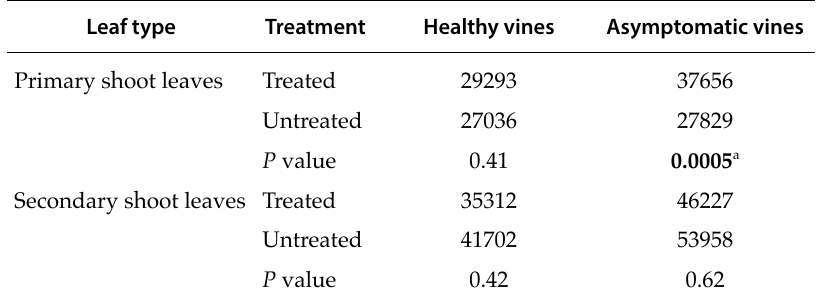
Figure 3 . Incidence and severity of esca foliar symptoms in two vineyards cv. Montepulciano d’Abruzzo (Teramo, Italy) after treatments with a mixture of CaCl 2 , Mg(NO 3 ) 2 and seaweed extract or its single components (a, b: 2011 and 2012, Montepulciano d’Abruzzo 1) and with the full mixture only (c, d: 2011 and 2012, Montepulciano d’Abruzzo 2). Table 4. Average leaf area (cm 2 ) in treated and untreated healthy and infected asymptomatic vines of the cv. Trebbiano d’Abruzzo in 2012 (24 vineshoots per